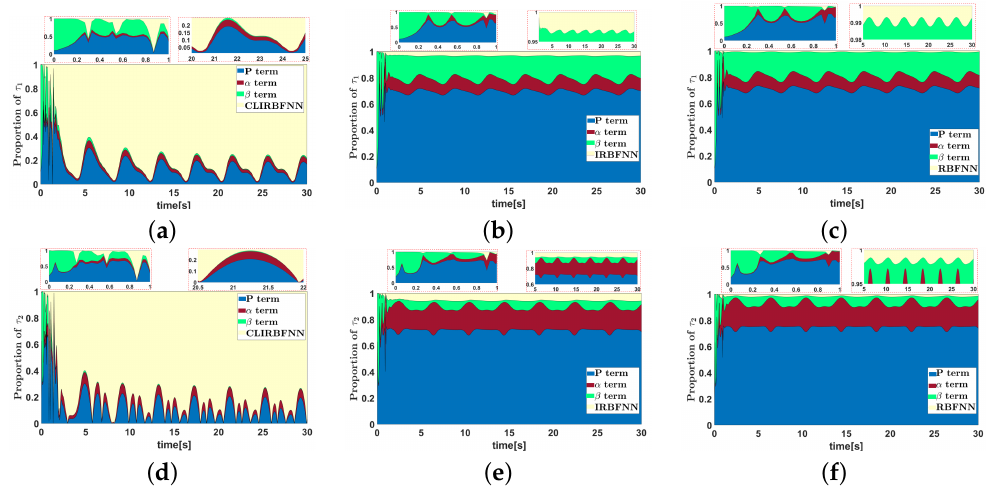
Figure 13. The torque ratio law under different NN control. ( a – c ) show the proportion of Joint 1. ( d – f ) show the proportion of Joint